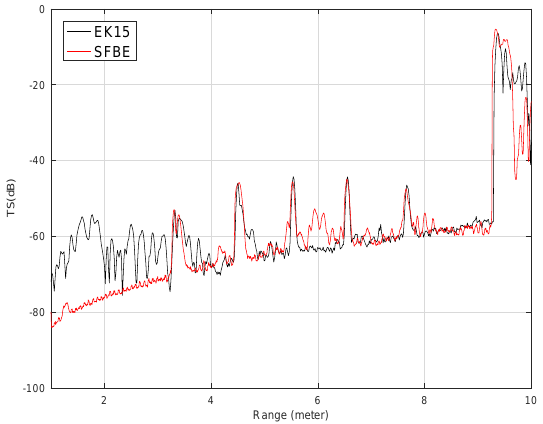
Figure 16. Average TS calculated for the depth range between 1 and 10 m when the 36.4 mm sphere was at 6 m.